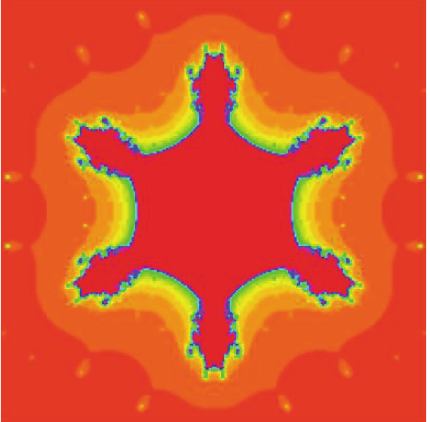
Figure 16: Relative superior multicorn for 𝑠 = 0.2 and 𝑠 󸀠 = 0.6 .